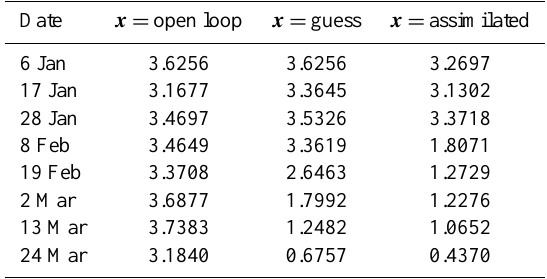
Table 2. Comparisons of RMSE (dB) between simulated ( σ snow = H( x ) ) and measured ( σ TSX ) reflectivities for different types of